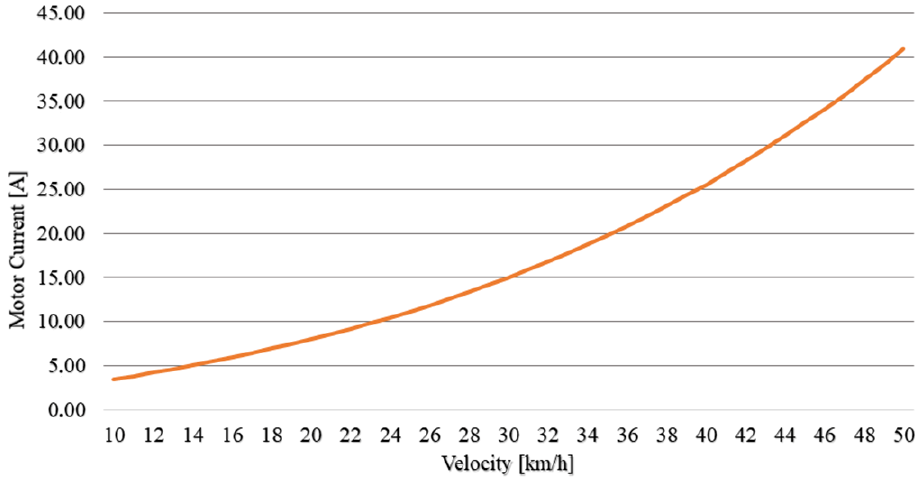
Figure 5. Relation between Motor Current and Velocity.